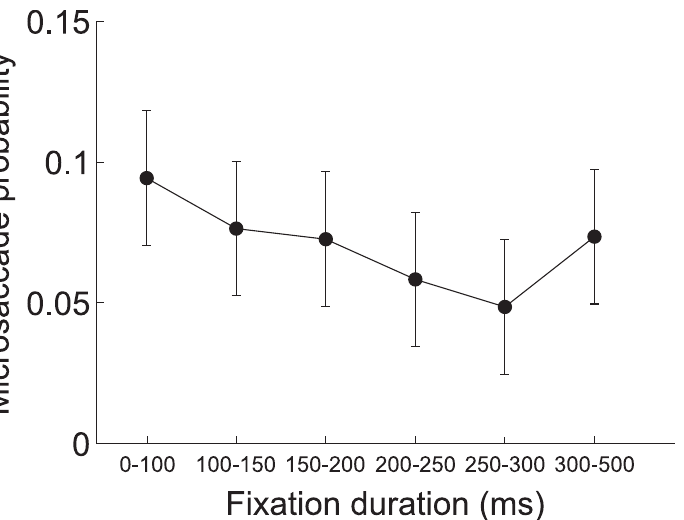
Fig 4. Microsaccades and fixation duration. Average probabilityof microsaccade occurrence as a function of the precedingfixation duration. Error bars represent 95% C.I.